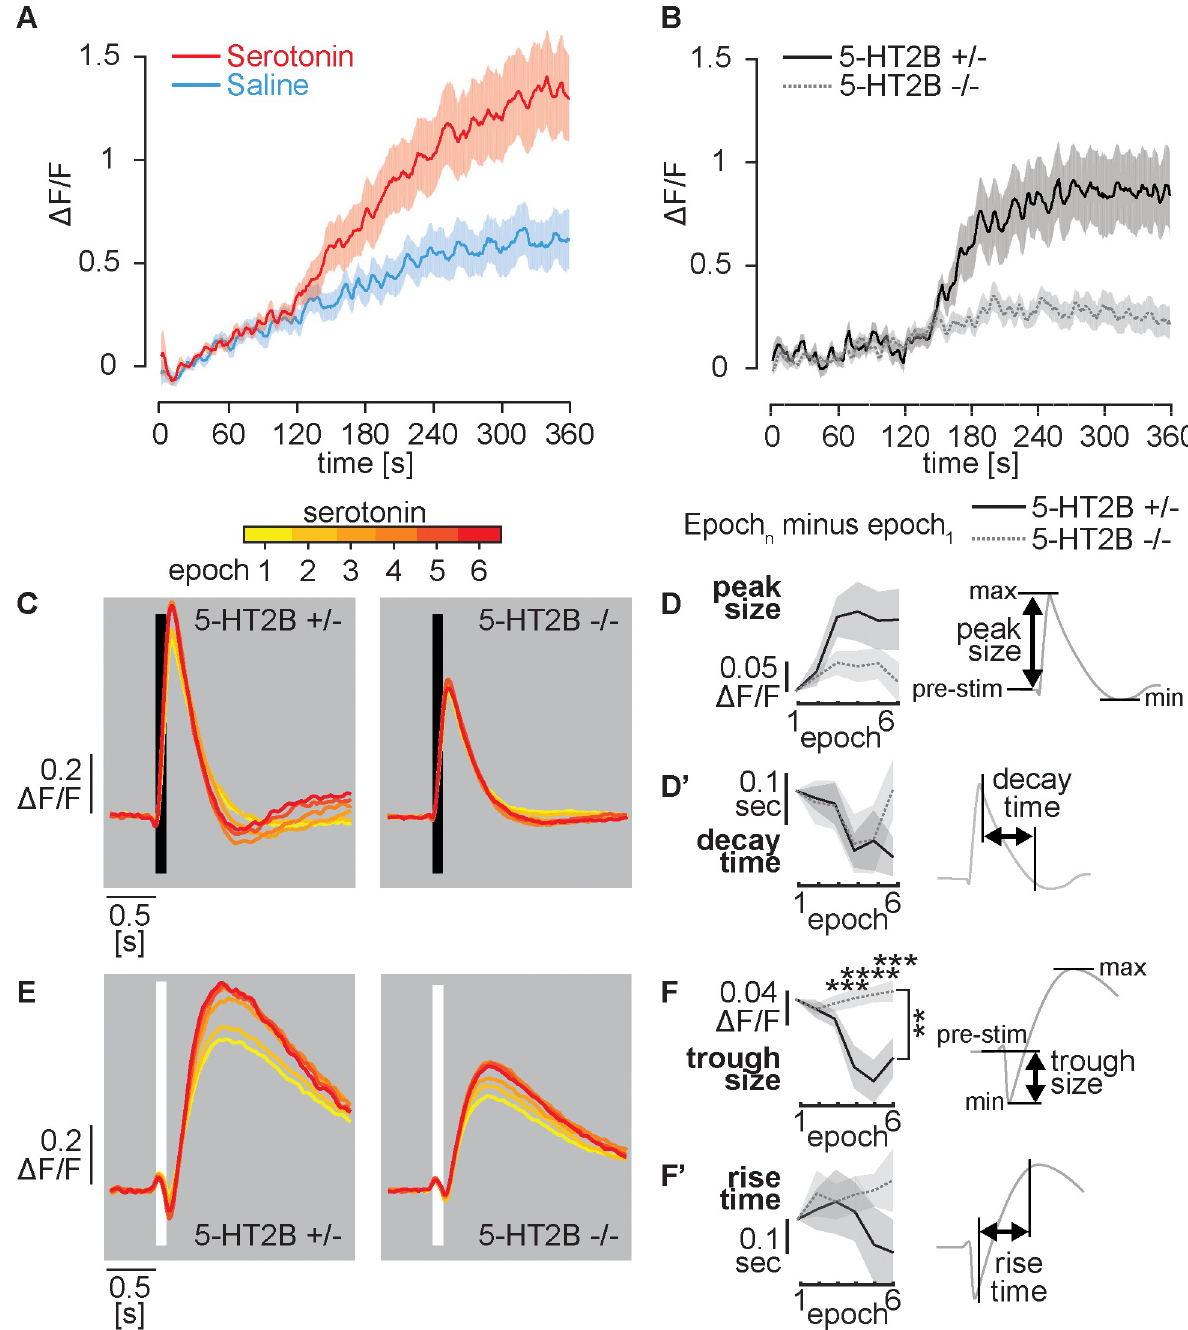
Fig 6. 5-HT2B mediates the L2 neuron response to serotonin. Perfusion with serotonin or saline alone was initiated ~105 s after baseline recording in saline as in Fig 5. ( A ) L2 > GCaMP6f response of wild 5-HT2B +/+ flies to serotonin versus saline perfusion in the absence of TTX. ( B ) L2 > GCaMP6f response of homozygous (5-HT2B -/-) and heterozygous (5-HT2B +/-) flies to serotonin perfusion. ( C-F ) Calcium transients following brief light or dark flashes in homozygous (5-HT2B -/-) and heterozygous (5-HT2B +/-) flies. Metrics and analysis are identical to those described in Fig 5. For (A), N = 14 serotonin and N = 20 saline exposed flies were tested. For (B-F), N = 13 5-HT2B +/- and N = 15 5-HT2B -/- flies, all receiving serotonin, were tested. Shaded areas show mean +/- SEM. Comparisons in (D, F) are two-way repeated measures ANOVA (brackets show interactions between time and genotype) and Sidak’s multiple comparisons tests for indicated time points, p � 0.01 �� , p � 0.001 ��� , p � 0.0001 ���� .